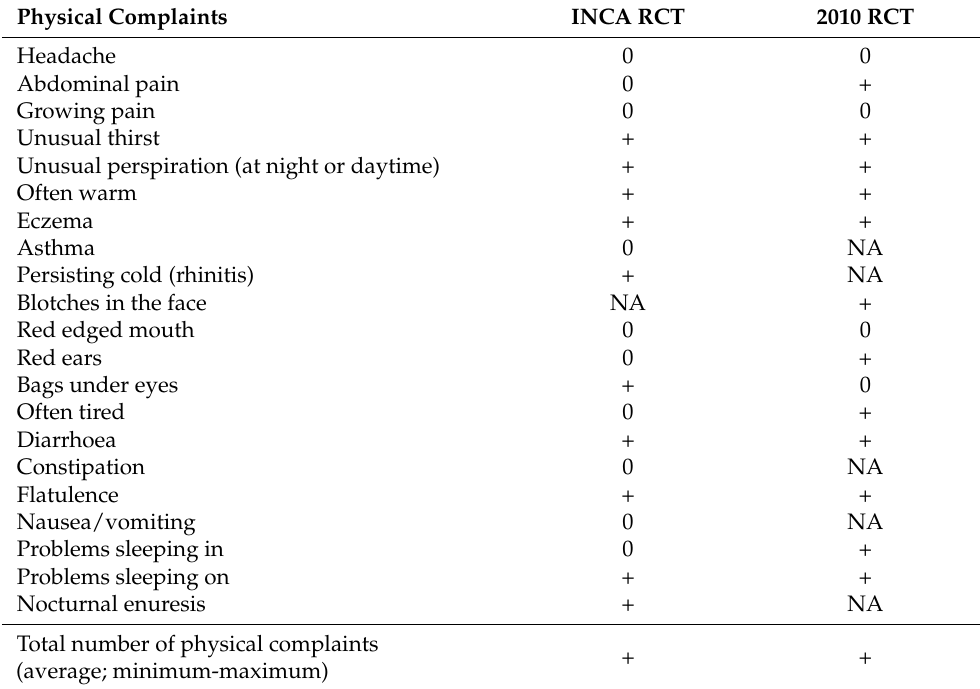
Table 5. Clinical relevance of associations between physical complaints and the few-foods diet in two RCTs, scored using the physical complaint questionnaire 1 before (T start ) and after (T end ) following the few-foods